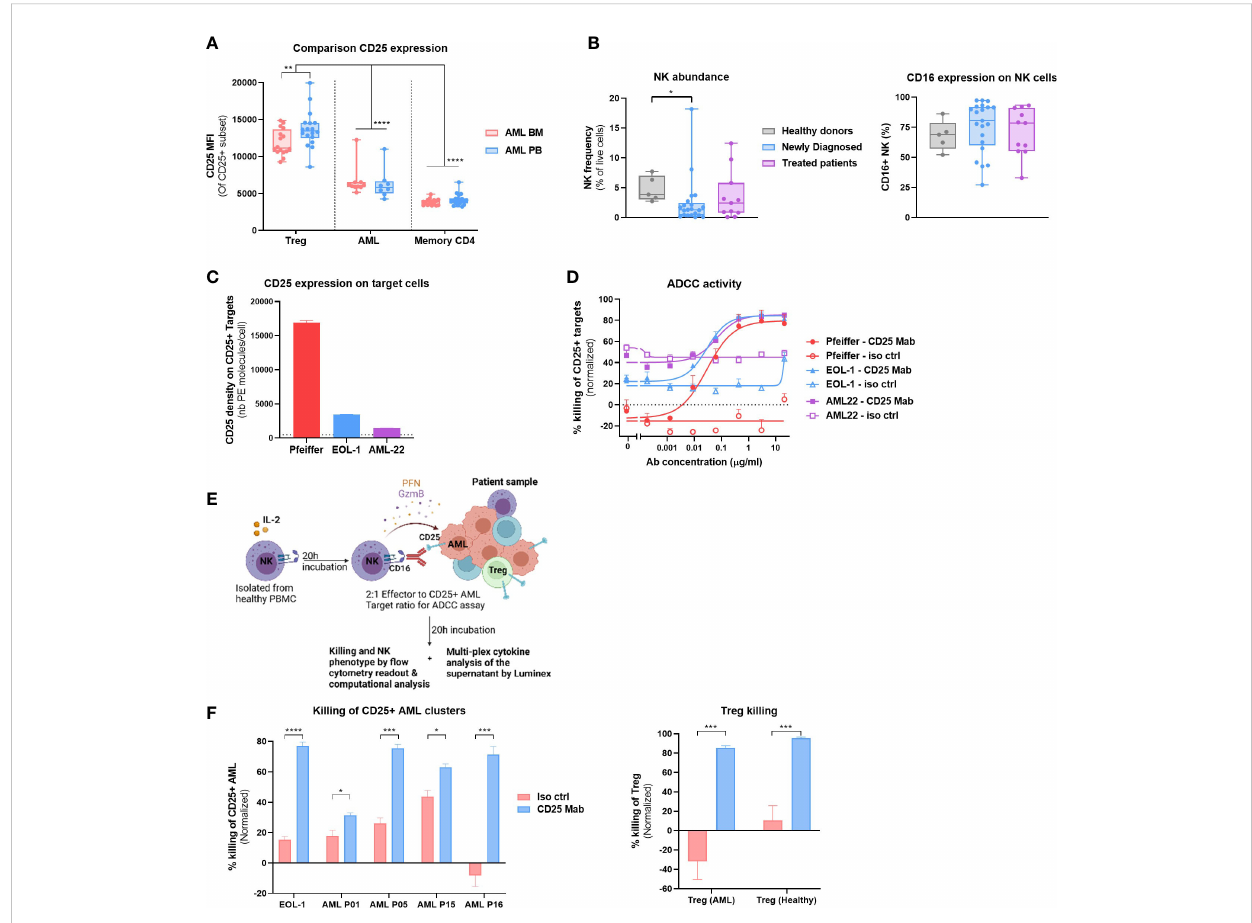
FIGURE 5 CD25 Mab depletes CD25+ AML and Tregs. (A) CD25 expression (MFI) on CD25+ Treg, AML cells or Memory CD4 T cells in Peripheral blood (PB, n = 22) or BM (n = 17) of samples analyzed in Study #2. Two-way ANOVA, Sidak ’ s multiple comparison test (for the comparison of BM vs PB) or Tukey ’ s multiple comparison test (for the comparison of expression between cell subsets). (B) Left: NK cell abundance (left) and CD16 expression on NK cells (right panel) in the BM of HD (n=5), Newly Diagnosed (n=22) and Treated patients (n=11). Data compiled from Study #1 and #2. Kruskal- Wallis with Dunn ’ s multiple comparison test. Right: Frequency of CD16+ NK cells. (C) Density of CD25 molecules on the surface of live target cells (Pfeiffer, EOL-1 and AML-22) in the absence of effector cells and test compounds was determined using BD quantibrite ™ Beads, 17h after ADCC assay initiation. The limit of detection (L.O.D) is represented by the dotted line and corresponds to the lowest number of PE molecules present on the BD quantibrite ™ Beads. (D) Dose response ADCC activity of the tested compounds (CD25 Mab or isotype control antibodies) as a frequency of CD25+ Target cell killing. Flow cytometric analysis was performed 17h after onset of ADCC assay. Mean +/- SEM represent results obtained with two NK cell donors and technical duplicates. EC50 values were calculated using GraphPad Prism and its inbuilt non-linear regression curve fi t (log (agonist) vs response, variable slope, 4 parameter)). (E) Graphical representation of the cytotoxicity assay with allogeneic NK cells and patient material to evaluate CD25 Mab dual mode of action hypothesis. Created with BioRender.com (F) Left: Killing activity of the tested compounds at 10 m g/ml (CD25 Mab or isotype control antibodies) as a frequency of CD25+ AML cell killing. See methods section for a detailed description of the experimental setup. Positive control EOL-1 cell line and four AML patient samples from study #2 were used as target cells. Flow cytometric analysis was performed 20h after onset of ADCC assay. Mean +/- SEM represent results obtained with two NK cell donors and technical duplicates. Right: Treg killing activity as described in left panel. Mean +/- SEM represent results obtained with AML Treg (n=3) or healthy BM Treg (n=2). Multiple t tests, Holm-Sidak correction for multiple comparisons. Signi fi cance levels are de fi ned in the methods section. P values > 0.05 are not indicated on the graphs. BM, Bone marrow; Treg, Regulatory T cell; NK, Natural Killer cell; ADCC, Antibody dependent cellular cytotoxicity. Signi fi cance levels are indicated as follows: ns or not indicated, not signi fi cant, P > 0.05; *P ≤ 0.05; **P ≤ 0.01; ***P ≤ 0.001; ****P ≤